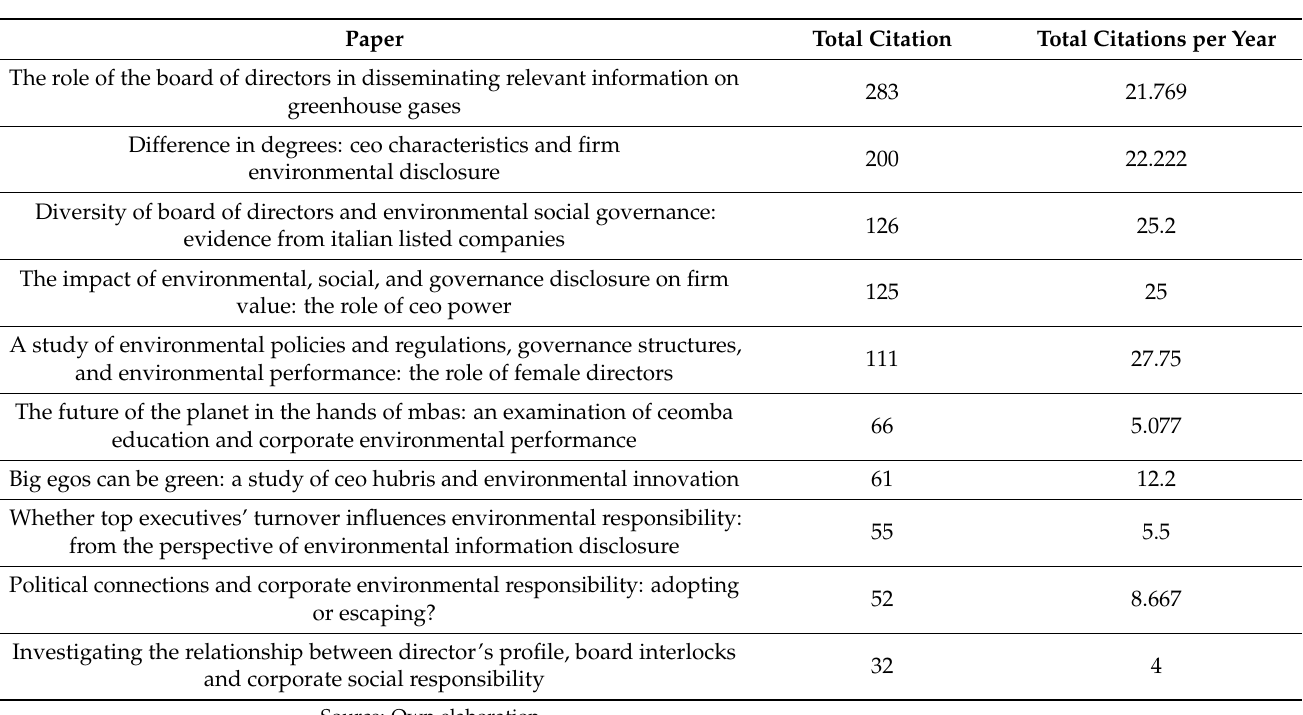
Table A3. Most globally cited